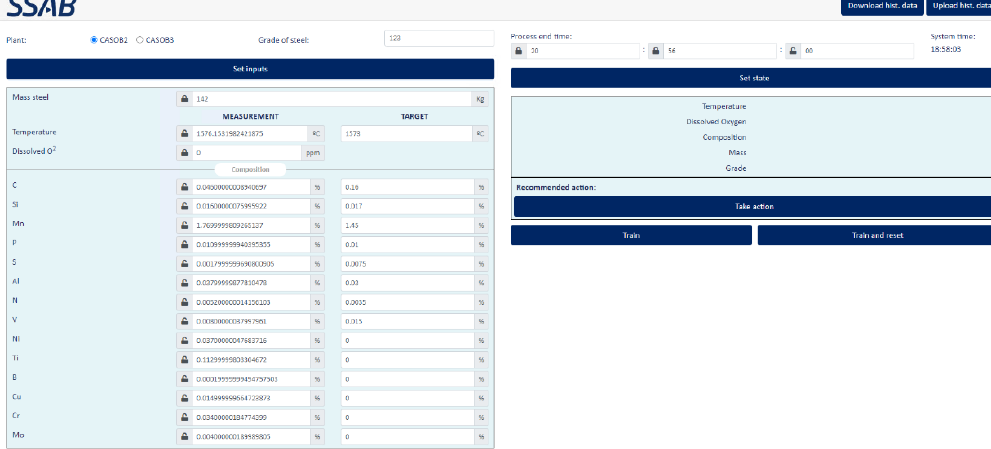
Figure 11. Decision support system online interface installed in CAS-OB